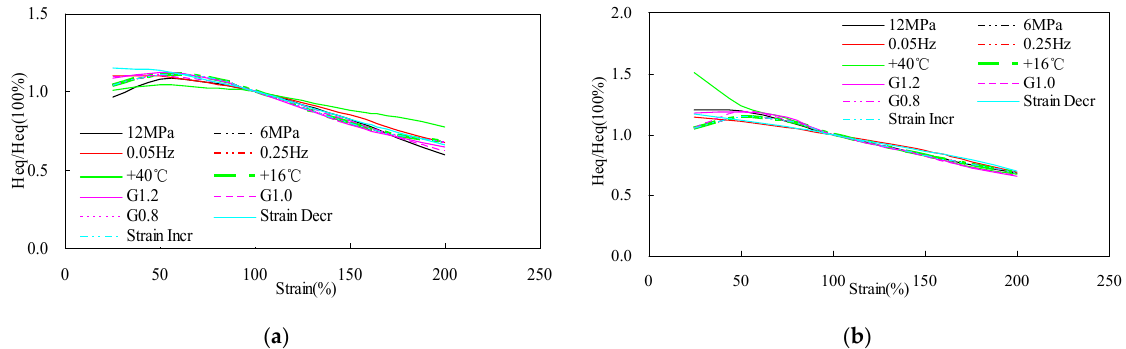
Figure 8. The mechanic properties eq H of bearings under different condition: ( a ) LRB; ( b ) SHDR.